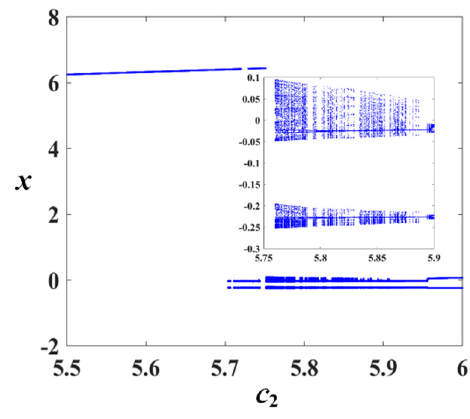
Figure 12. The bifurcation diagram of the HNN varying with crosstalk parameter c 2 .